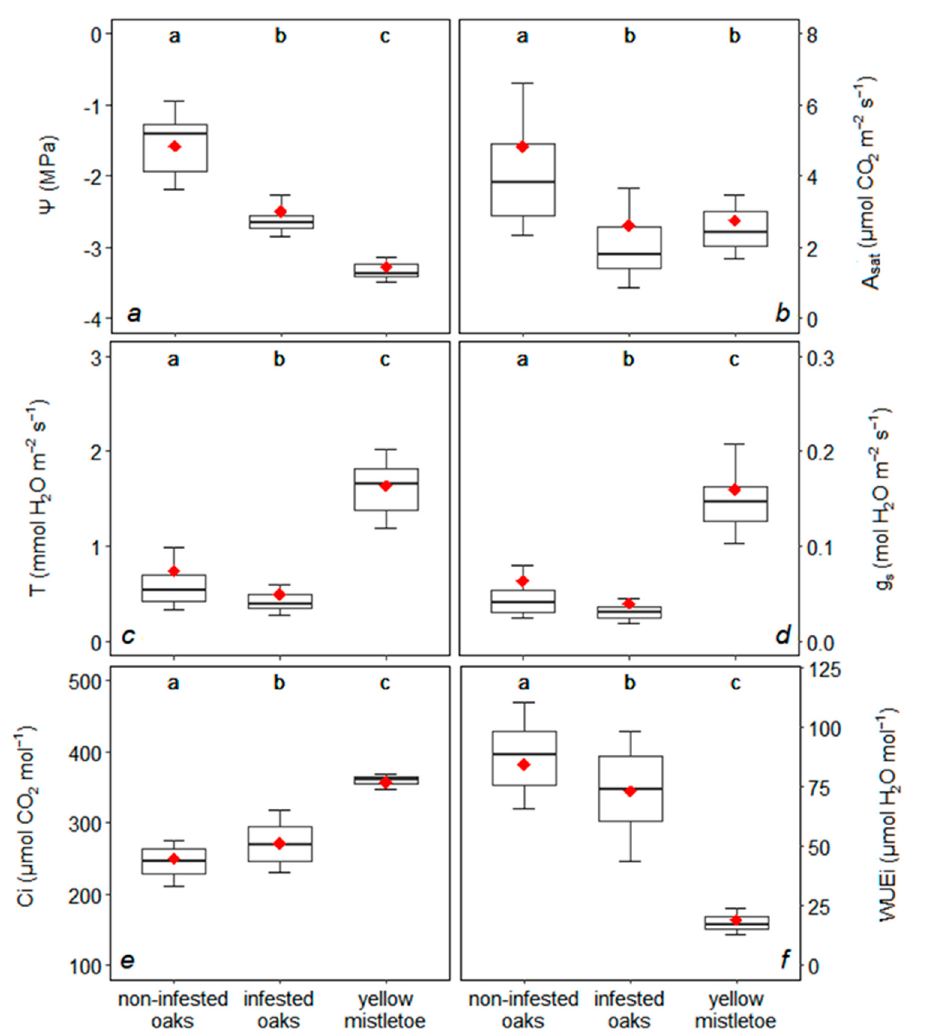
Figure 2. Water potential ( Ψ , ( a )), assimilation rate (A sat , ( b )), transpiration rate (T, ( c )) stomatal conductivity (g S , ( d )), intercellular concentration of CO 2 (Ci, ( e )) and intrinsic water-use efficiency (WUEi, ( f )) of non-infested oaks, infested oaks and yellow mistletoes. The median (black line), 25% quantile (box; 37.5–62.5%), 50% quantile (whiskers; 25–75%) and mean (red diamond) are displayed. Lowercase letters represent statistical significance at the level of p = 0.05.